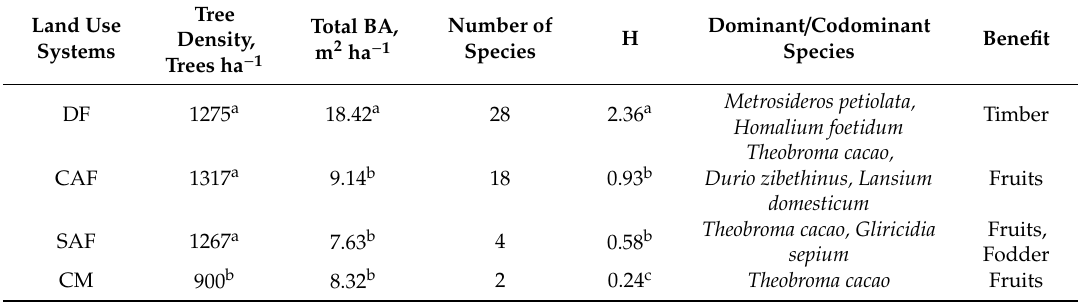
Table 2. Structure and diversity of cacao systems compared to degrded forest (H = Shannon index; DF = Degraded forest; CAF = Cacao complex agroforestry; SAF = Cacao simple agroforestry; CM = Cacao